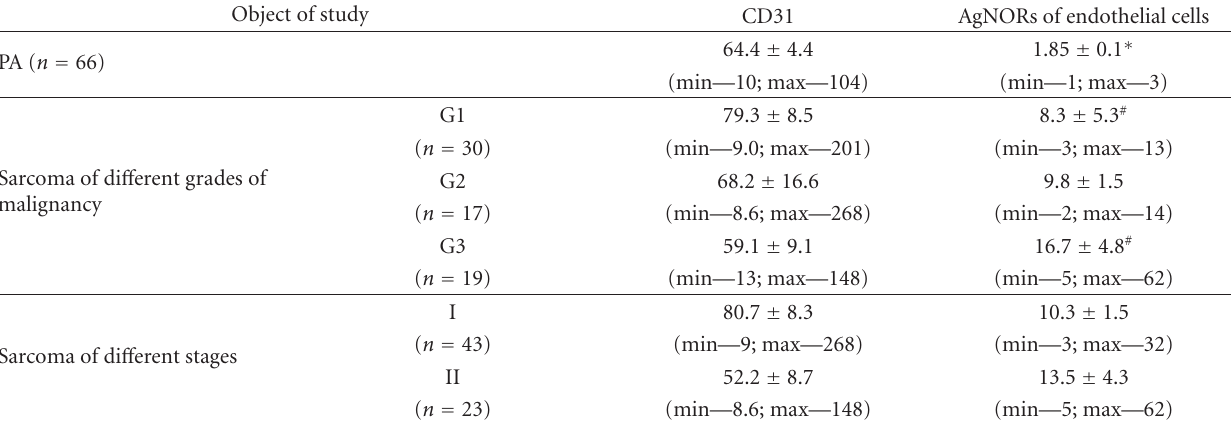
Table 2: The number of AgNORs of endothelial cells and the MVD in the PA and LMS of di ff erent stages and grades of malignancy.